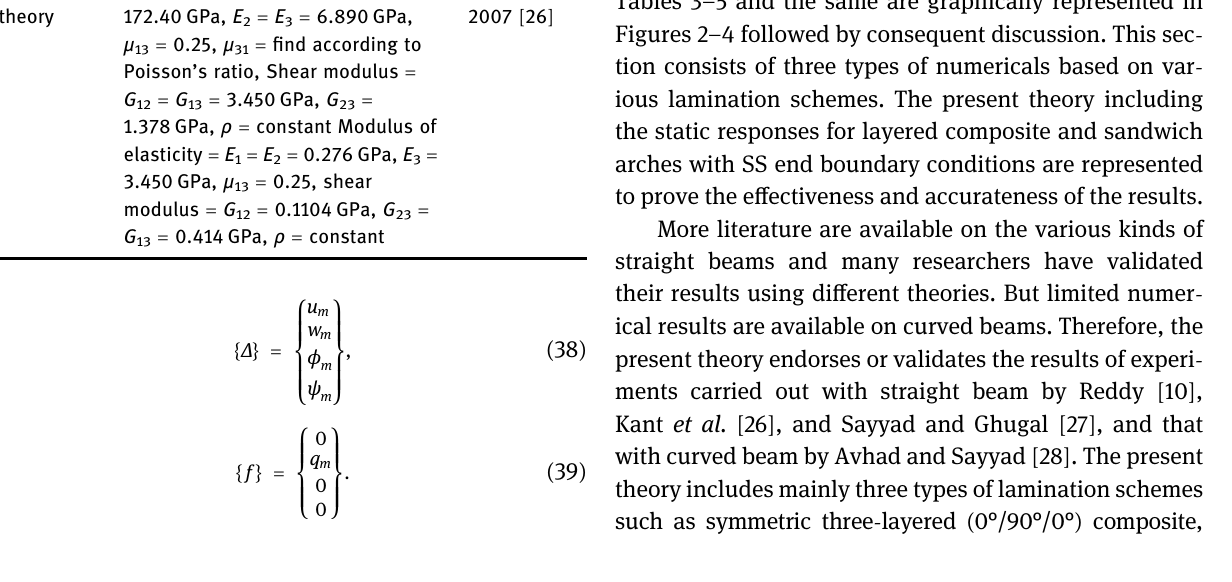
Table 3: Assessment of non - dimensional transverse shear stresses, axial displacements, transverse displacements, and axial bending stresses for antisymmetric two - layered ( 0°/90° ) composite arches